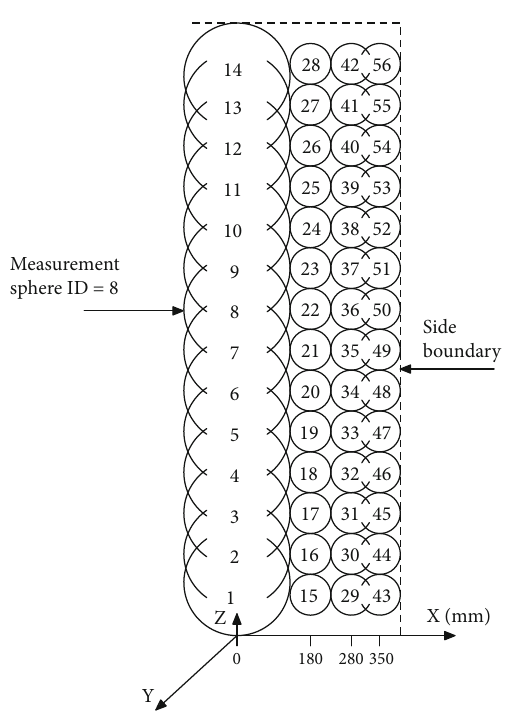
Figure 3: Position of measurement spheres within the